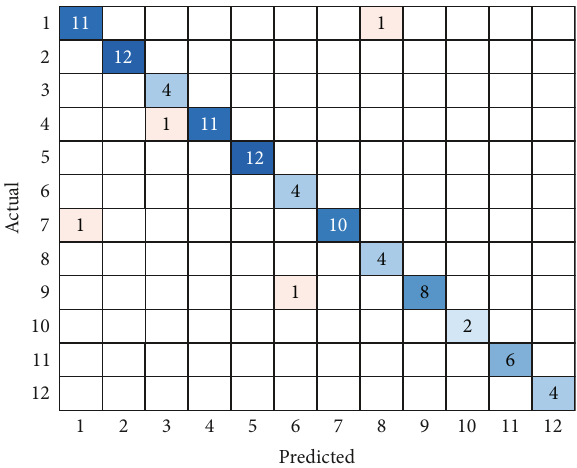
Figure 12: Time series visualization result.